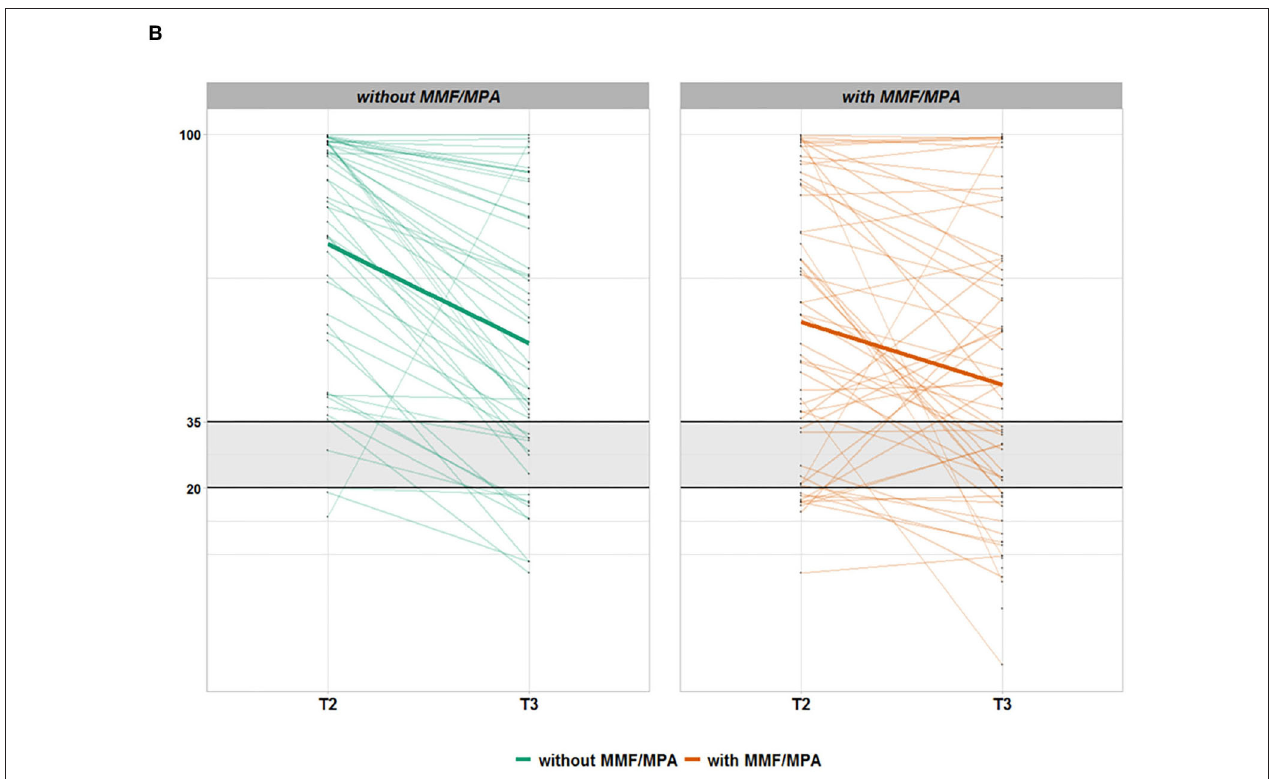
FIGURE 2B | Time course of anti-SARS-CoV-2 RBD-IgG antibodies in seroconverted kidney transplant recipients (KTR) without (green) or with (orange) mycophenolate mofetil or mycophenolic acid (MMF/MPA) treatment. Each thin line corresponds to the anti-spike S1 protein RBD-IgG antibody values (Euroimmun) of a study participant from T2 (8 weeks after vaccination start) to T3 (6 months after vaccination start). KTR being treated without MMF/MPA are represented in green and KTR exposed to MMF/MPA treatment are shown in orange. Only patients with successful de novo seroconversion at T2 (IgA or IgG antibody positivity against the SARS-CoV-2 S1 protein) after 2x mRNA vaccination and without SARS-CoV-2 nucleocapsid (NCP) antibodies were considered. The area shaded gray designates RBD-IgG borderline range below positivity level. The vertical axis is depicted on log 10 scale with corresponding unit %